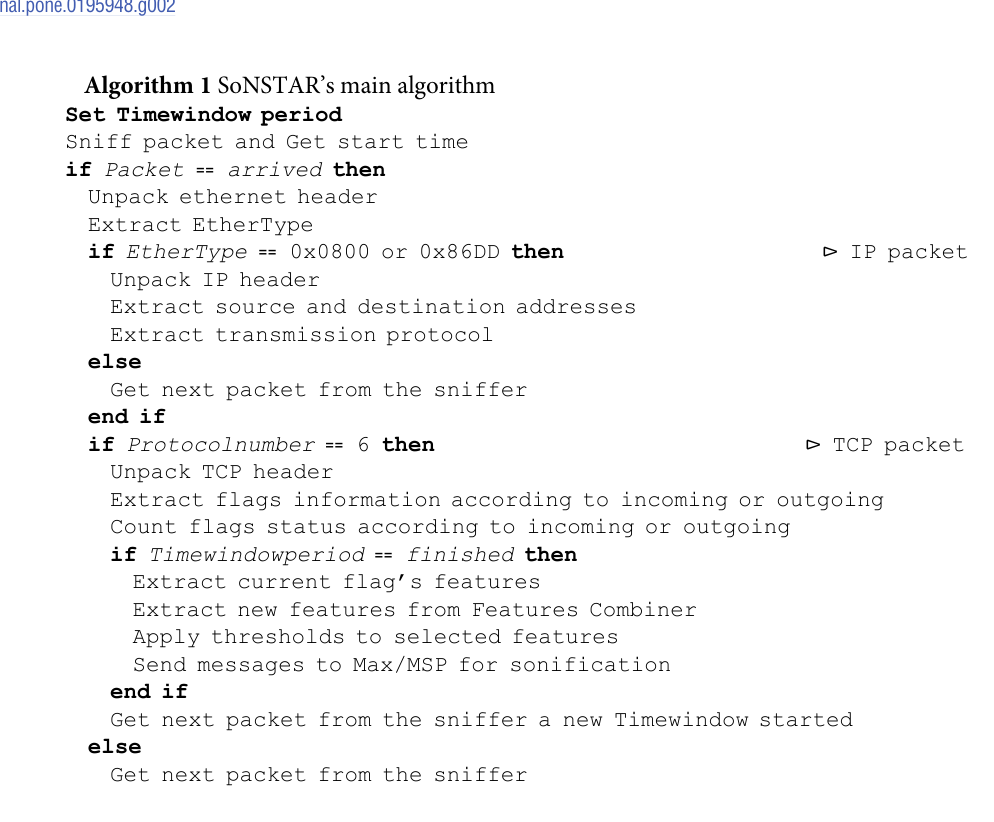
Fig 2. Time window processes. SoNSTAR aggregates flow data across time windows. This figure shows the process timing and sequencing across two time windows, X and Y .